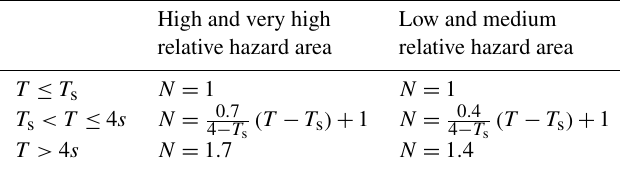
Table A3. N (spectral modification factor) calculation equations (BHRC,